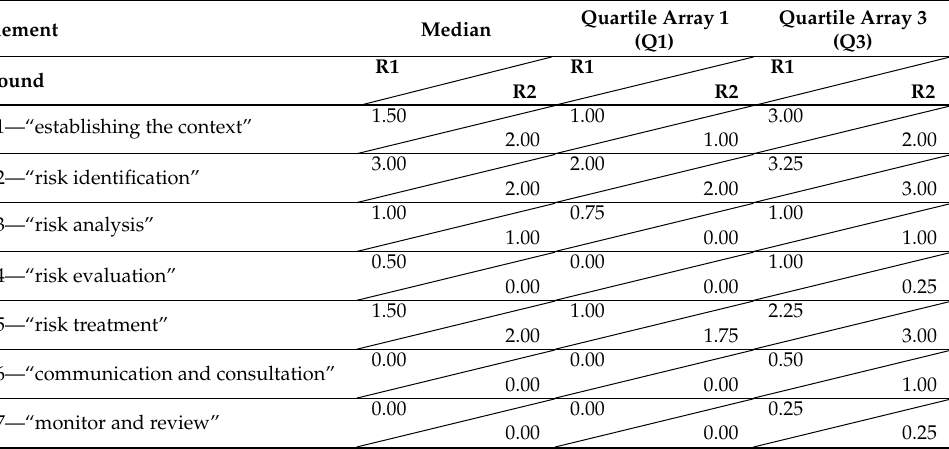
Table 5. Medians and interquartiles agreed upon competency ratings for rounds one and two for the control group for the seven elements of the risk management